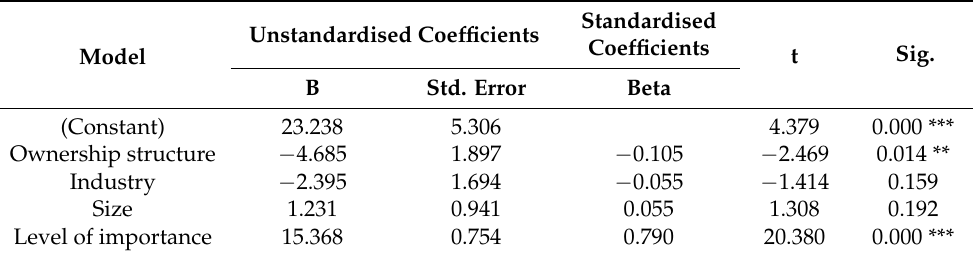
Table 3. Regression model—reporting score is dependent, and ownership structure, industry, size and level of importance are independent